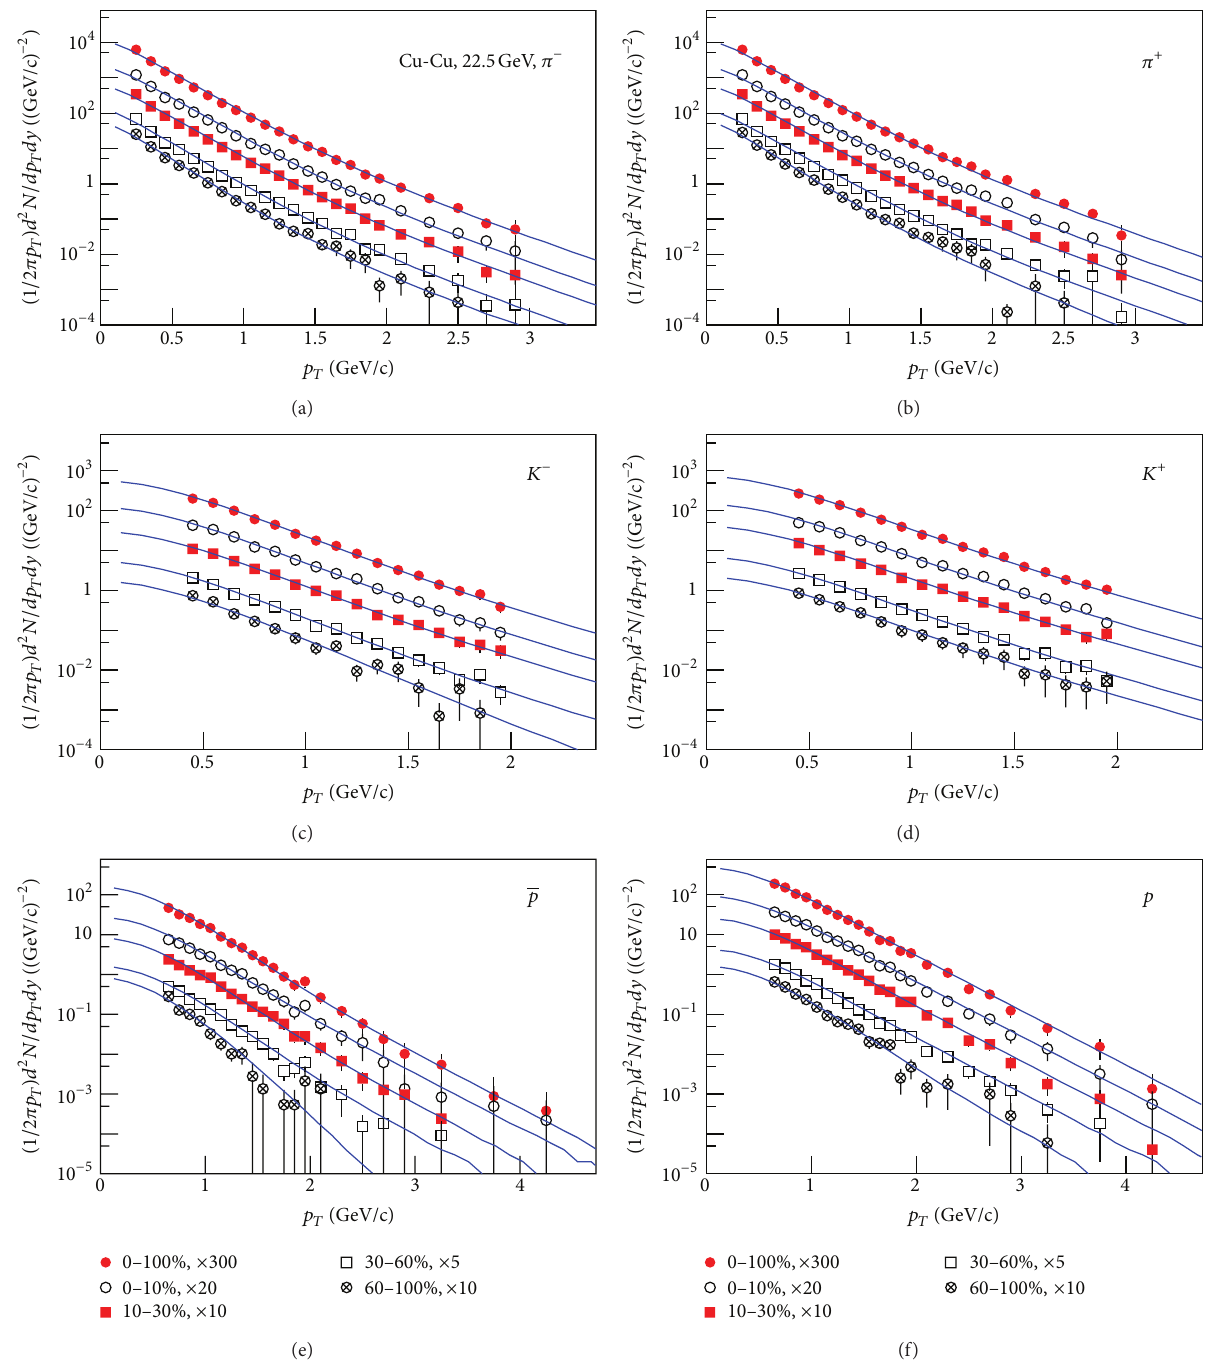
Figure 4: The transverse momentum distributions of (a) 𝜋 − , (b) 𝜋 + , (c) 𝐾 − , (d) 𝐾 + , (e) 𝑝 , and (f) 𝑝 produced in Cu-Cu collisions at √𝑠 𝑁𝑁 = 22.5 GeV with different centrality classes and magnifications are shown in the figure. The symbols represent the experimental data of the PHENIX Collaboration [32] and the curves are our results calculated by the Boltzmann or two-component Boltzmann